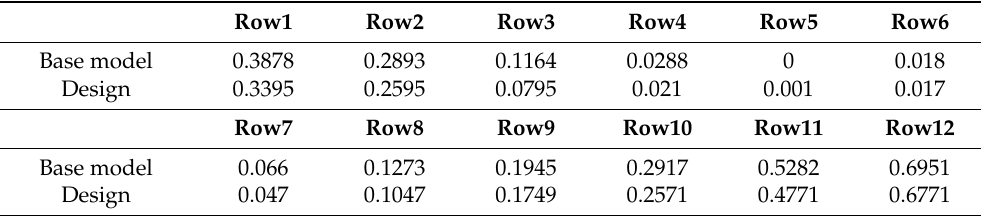
Figure 10. The film cooling effectiveness distribution for the base model and the design. Table 6. Design results: design variables (normalized with the axial length of the airfoil; adapted with permission from [16]; copyright 2021 Korean Society for Fluid Machinery).